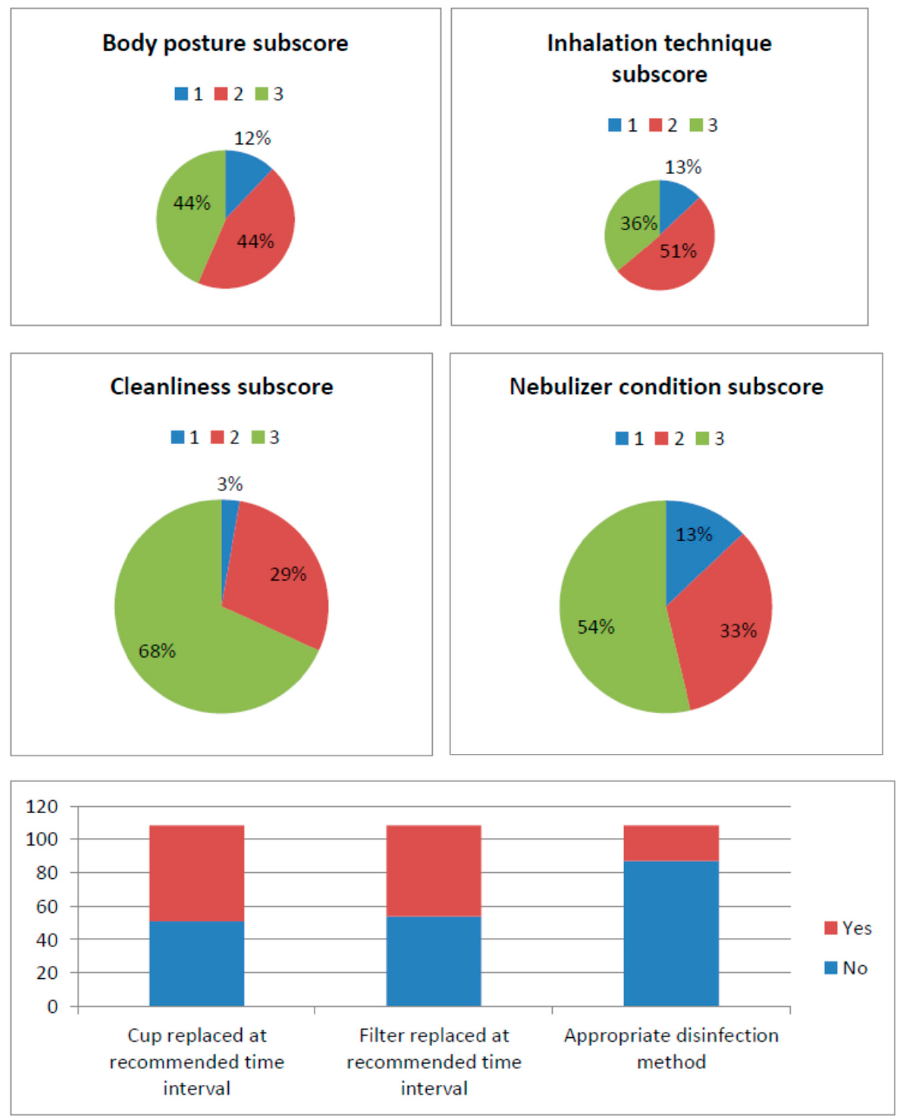
Figure 1. Patient inhalation technique and nebulizer disinfection/maintenance subscores.